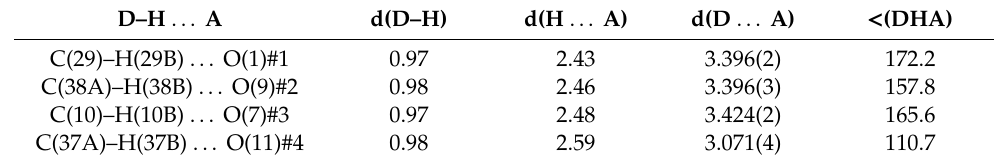
Figure 4. Pairs of hydrogen bonds form an inversion dimer (orange dashed line) which are linked into chains along the a -axis.